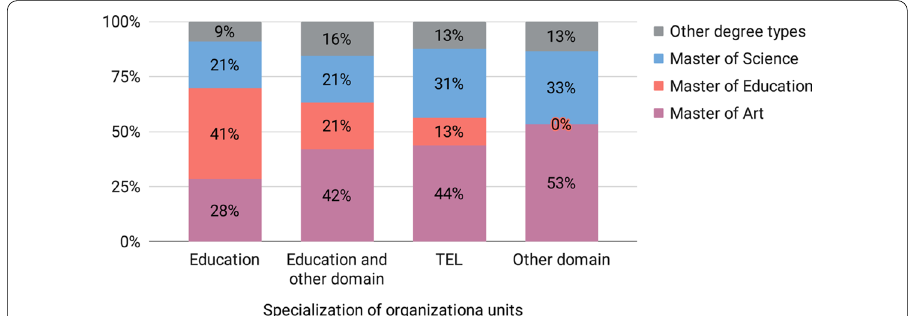
Fig. 3 Degree types of the four largest groups of organizational